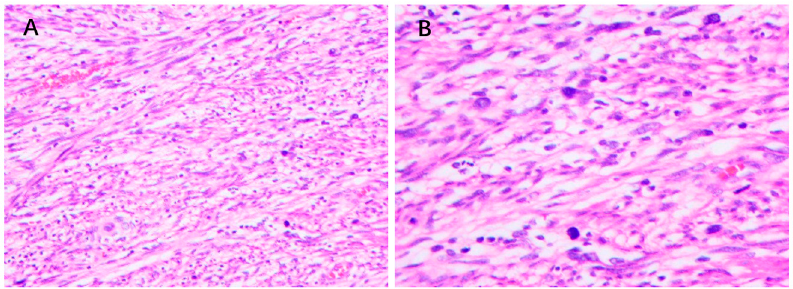
Figure 5. Histological appearance of MPNST. hematoxylin-eosin staining for MPNST ( A ) magnification 200× ( B ) magnification 400× The cells are elongated into a spindle-like shape with a hyperchromatic nucleus. Cell necrosis and mitosis are common in MPNST.